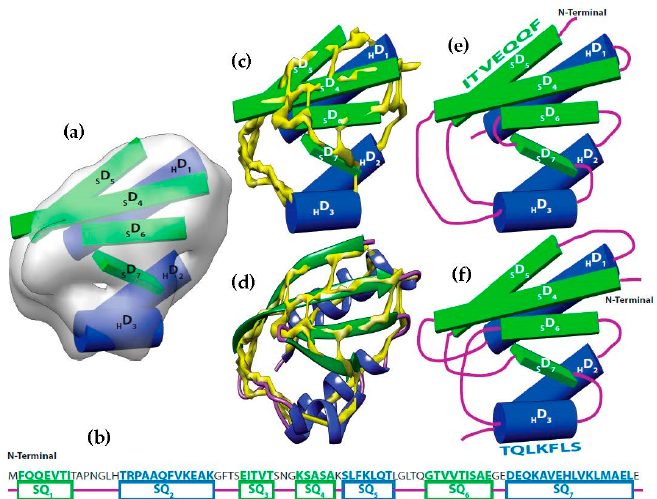
Figure 1. Topology problem. ( a ) The volume and the sticks detected for SSEs-V. The volume was simulated at 10 Å resolution using protein structure 1POH (PDB ID). Three helix sticks (blue) and 4 strand sticks (green) were detected from the volume; ( b ) The SSEs-S observed from protein sequence are marked as SQ 1 to SQ 7 . Helix segments were colored in blue and β -strands were colored in green; ( c ) The helix sticks were superimposed to the skeleton (yellow) that was generated using the initial version of our skeletonizer [47]; ( d ) The native protein structure was superimposed to the skeleton. ( e ) The correct topology of the SSEs; ( f ) An example of a wrong possible topology.